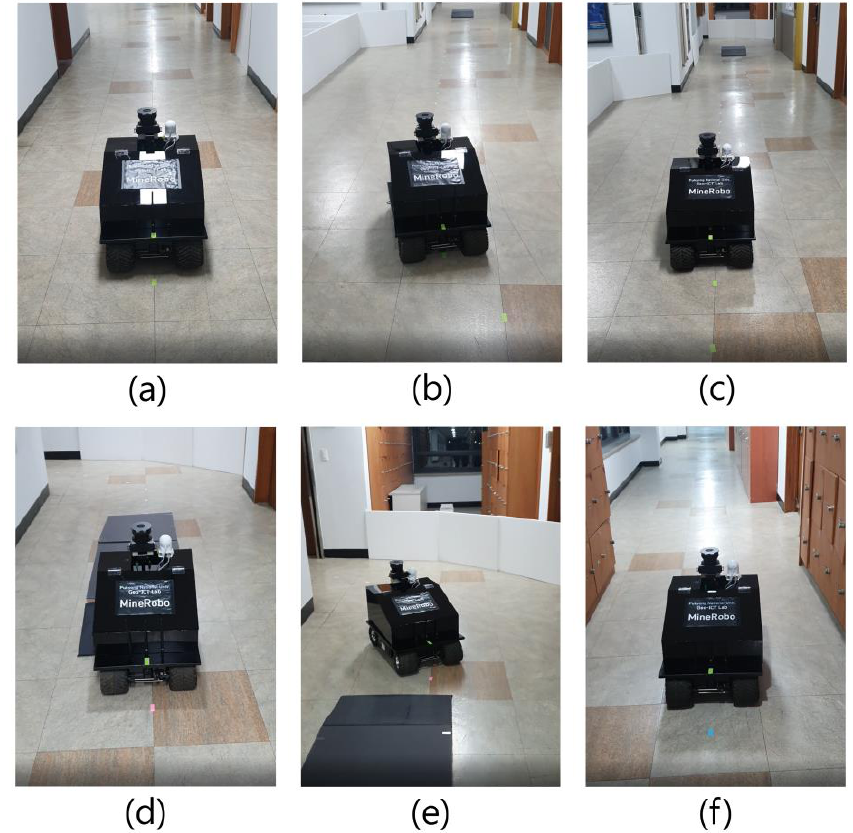
Figure 6. Photos showing indoor experimental scenes of the autonomous driving robot ( a ) at the starting point, ( b ) X change section, ( c ) X-Y change section, ( d ) X-Z change section, ( e ) Y change section, and ( f ) the end point.